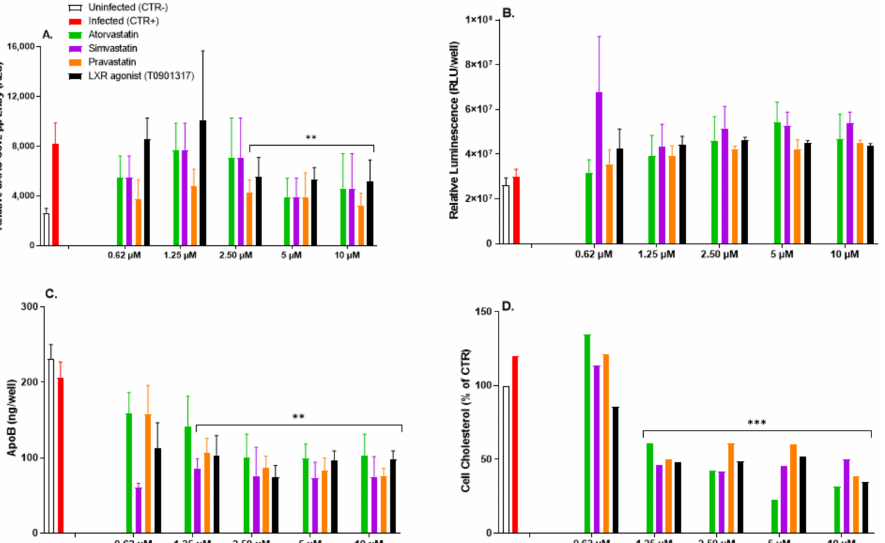
Figure 7. Alteration in intracellular cholesterol by statins reduces SARS-CoV-2pp entry into cells. Huh7 cells were treated with increasing concentrations of various classes of statins and the LXR agonist T0901317 for 48 h prior to cell infection with SARS-CoV-2pp (35,000 RLU/mL). At 48 h p.i., cells were used to measure the virus entry into cells by a luciferase assay ( A ), cell viability ( B ), apoB-LDL by ELISA ( C ), and the cellular cholesterol content ( D ). Values are plotted as the mean ± SD (N = 3, except for cholesterol content, N = 2). p values were calculated using a two-tailed Student t -test. ** p < 0.001, and *** p < 0.0001 vs. infected group